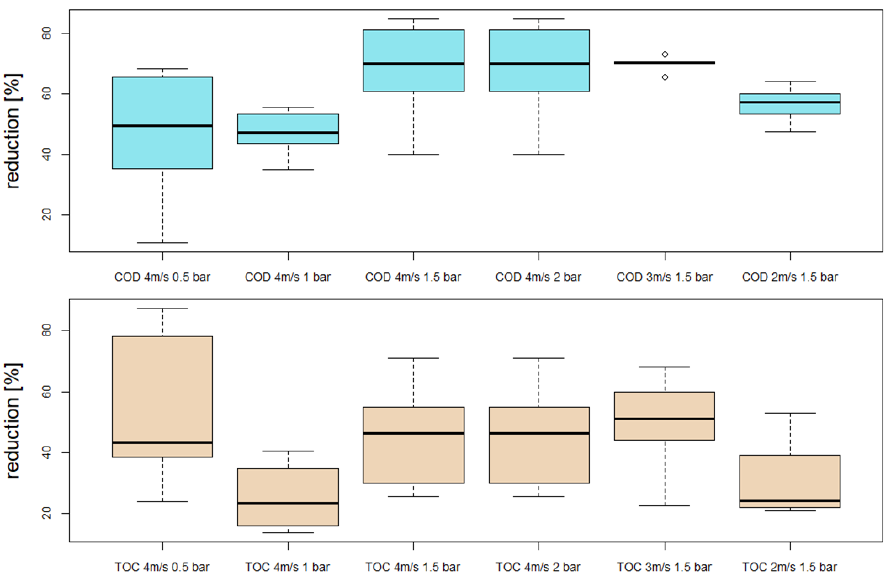
Figure 8. Rejection of COD and TOC in dependence of cross-flow velocity and transmembrane pressure.